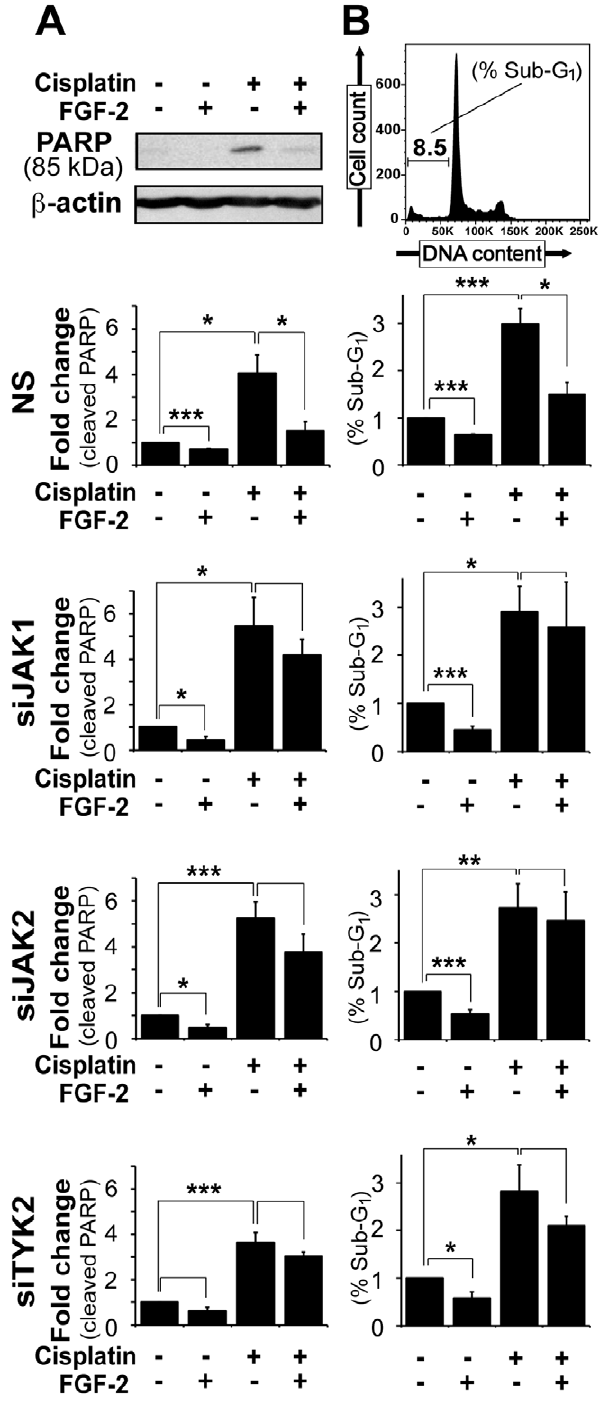
Figure 3. Knockdown of JAK1, JAK2 or TYK2 blocked the ability of FGF-2 to prevent cisplatin-induced apoptosis in U2OS cells. Cells were transfected with 75 nM of siRNA against JAK1, JAK2 or TYK2. Untransfected cells and cells transfected with non-specific siRNA (NS) were used as controls. After 48 h, cells were re-plated (2 6 10 5 cells/well) and incubated in serum-free media overnight. After 4 h pre-treatment with FGF-2 (10 ng/ml), cells were treated with cisplatin (60 m M) overnight. A. Mean 6 SEM of densitometric values (cleaved PARP) from three experi- ments are shown. B. Cell cycle profiles of three independent experiments are graphically represented as mean 6 SEM of sub-G1 populations. The top panels exemplify the data and correspond to control cells.